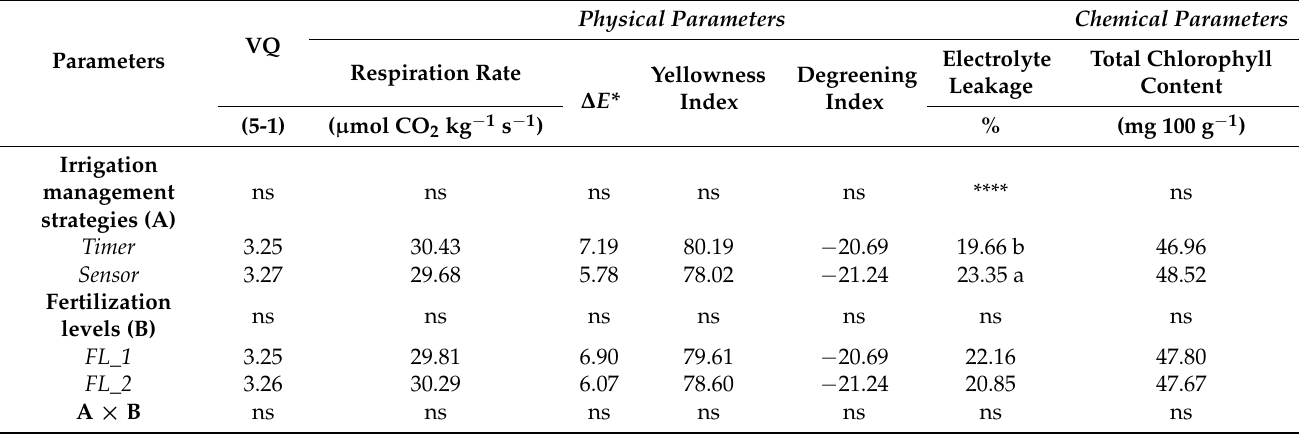
Table 2. Effects of irrigation management strategies (Timer or Sensor) (A), fertilization levels (FL_1 or FL_2) (B) and their in-teraction on visual quality, physical and chemical parameters of rocket leaves stored at 10 ◦